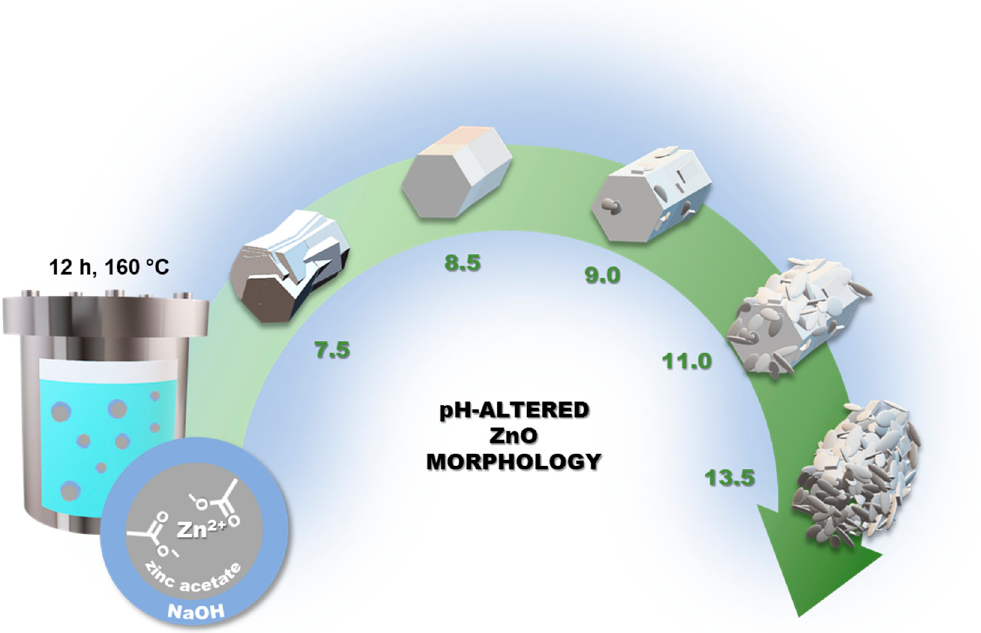
Figure 12. Scheme of pH-altered (7.5–13.5) ZnO hydrothermal synthesis, resulting in hexagonal pellets and plate-like particles.